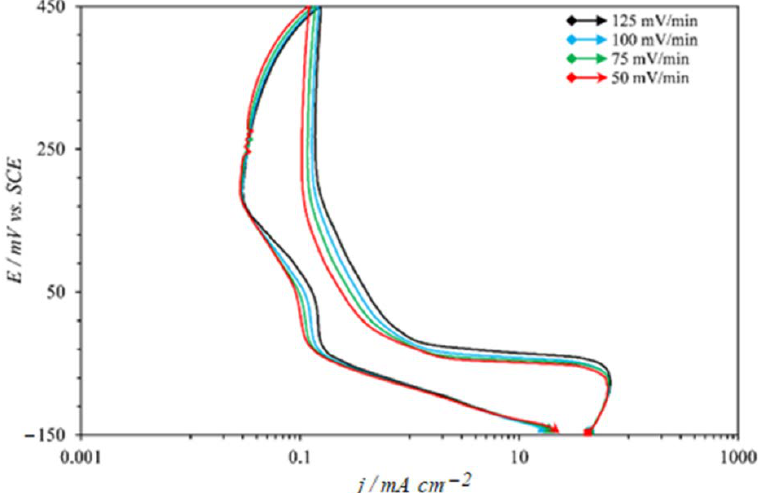
Figure 6. Polarization curves in 0.5 M sulfuric acid with 50 ppm of KSCN reactivator.